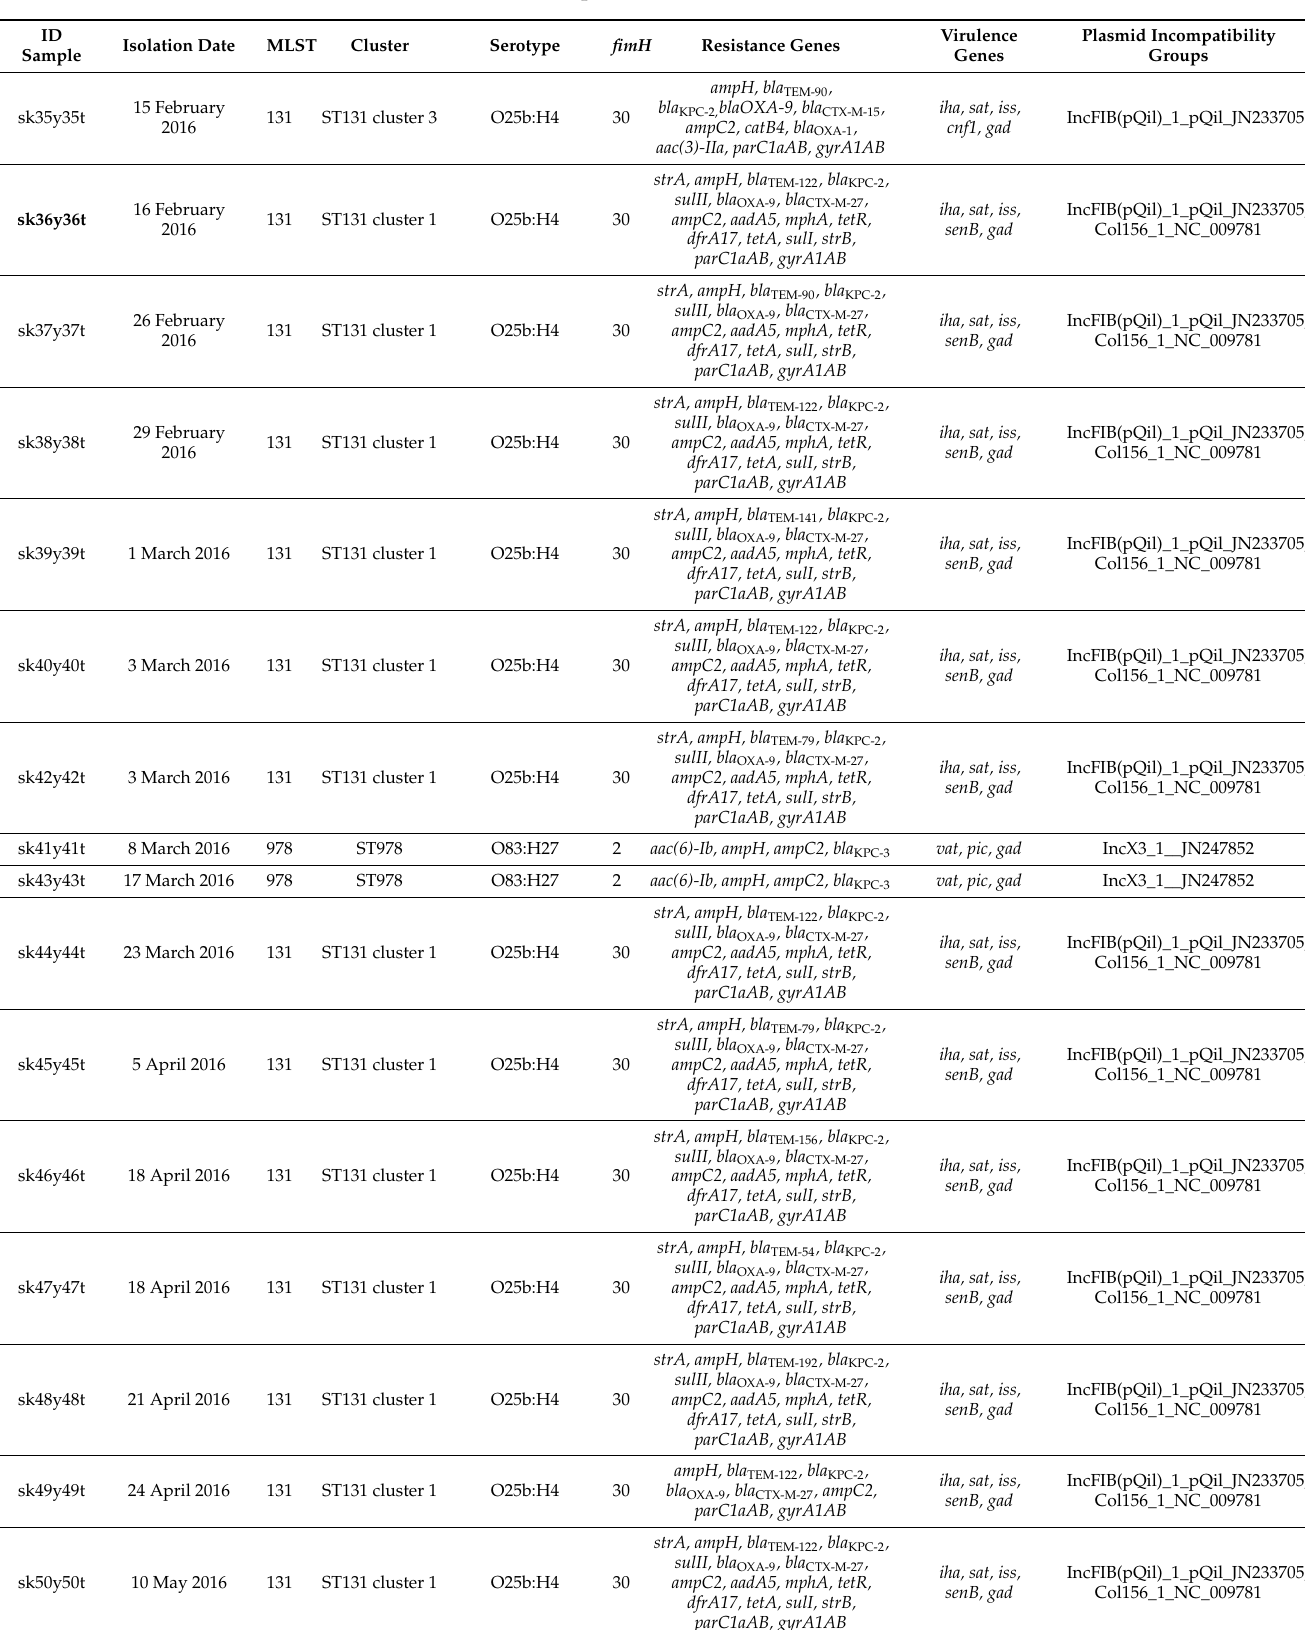
Table 3. Genomic characteristics of the sequenced isolates. The “index strain” is indicated in